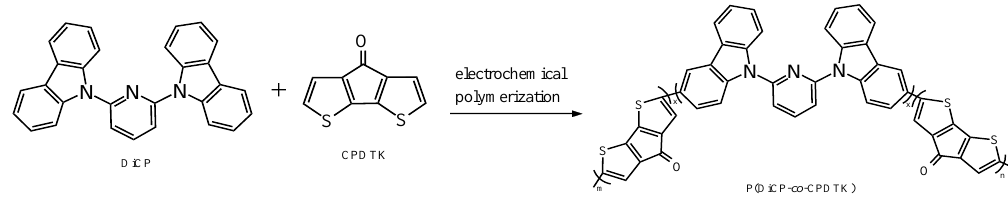
Figure 1. The electrochemical polymerization schemes of PDiCP, P(DiCP- co -CPDT), and P(DiCP- co - CPDTK).